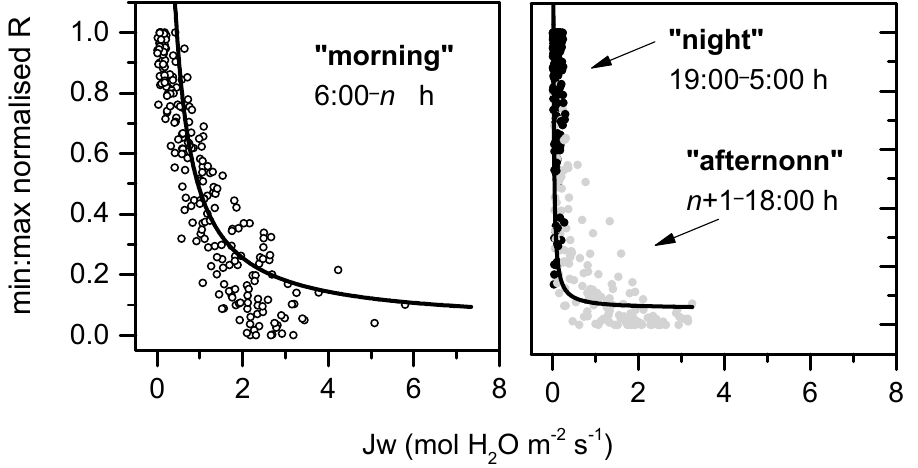
Figure 6. Correlation between R signal and the water flux density (Jw) hourly measured in olive trees during (top panel) “morning” ( ○ ) and (bottom panel) “afternoon” (•, grey filled) and “night” (•, black filled). The n + 1 h indicates the time of the day (between 13 and 15 h) corresponding to that when Jw become lower than that measured at time n. Note that scatters have been fitted using the model y = a + b/x consistent with that of the ions’ concentration expected in the xylem, lines are illustrative only.